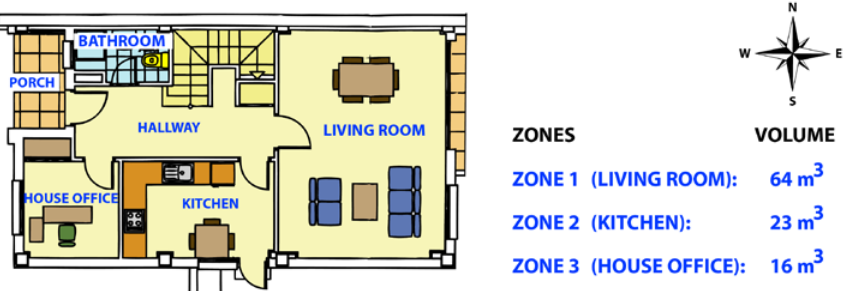
Figure 15. Map of the control zones and their respective volumes.